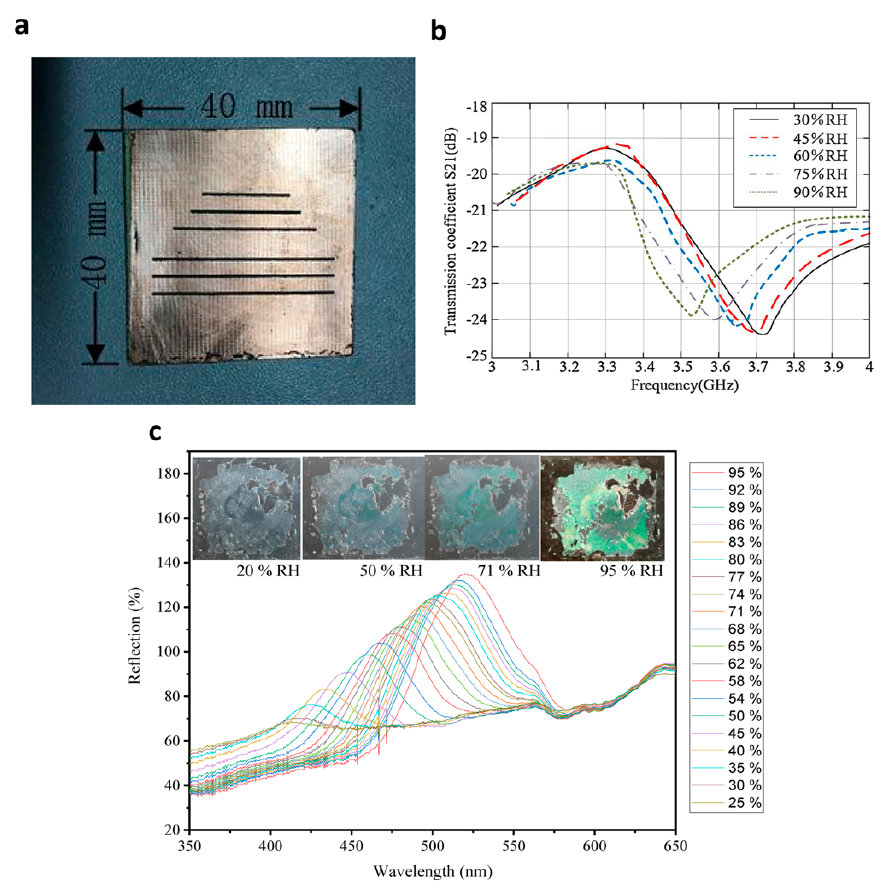
Figure 3. ( a ) Photo of a generic humidity-based sensor radio frequency identification (RFID) tag and ( b ) transmission coefficient S21 of the sensor unit at 25 °C. Reproduced with permission from [126]. Copyright © 2018 Elsevier B.V. All rights reserved. ( c ) Spectra shift of an opal hydrogel composite by increasing RH (%). Reproduced with permission from [134]. Copyright © 2020 Published by Elsevier Ltd.